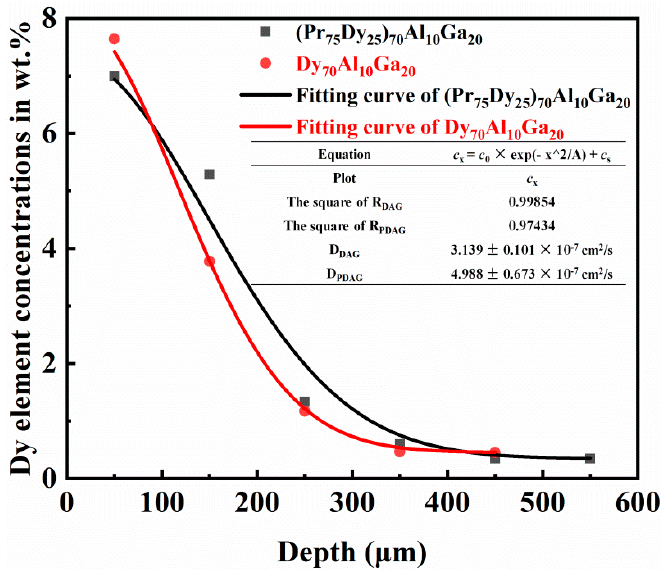
Figure 8. The fitting curves of Dy element concentration in (Pr 75 Dy 25 ) 70 Al 10 Ga 20 diffused magnets at different depths.